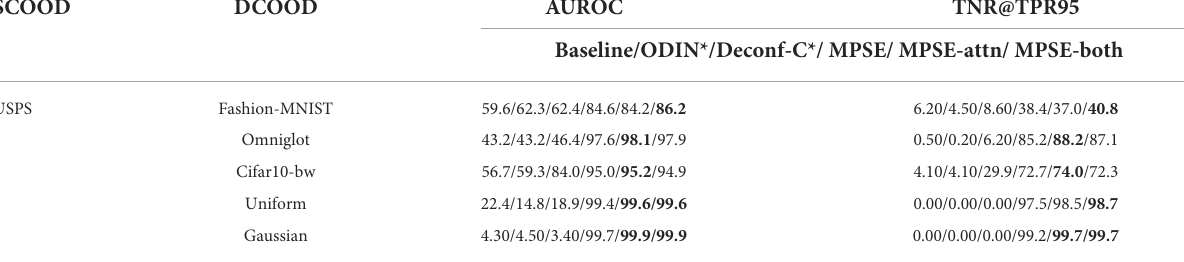
TABLE 2 The model was trained using only the ID dataset (MNIST) to discriminate the performance of SCOOD against DCOOD data, and the best results are shown in bold. SCOOD